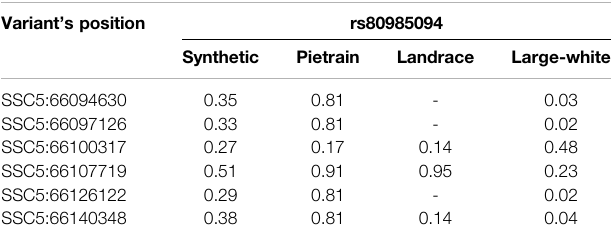
TABLE7| Linkagedisequilibrium(r2)betweentheleadSNPandthe660Kvariants present in the core